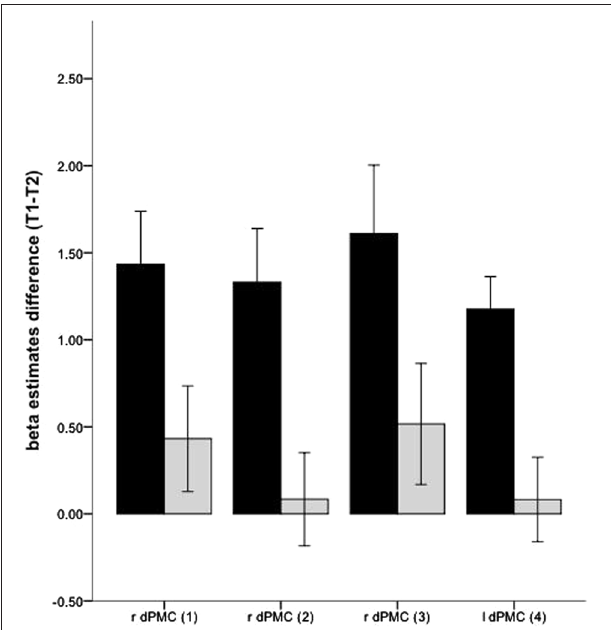
FIGURE 3 | Interaction effects for changes of neuronal recruitment during MI, between the golf (black) and the control (gray) group: dPMC, dorsal premotor cortex. The indices relate to the numbers used in Table 4 and Figure 2 . Error bars represent 1